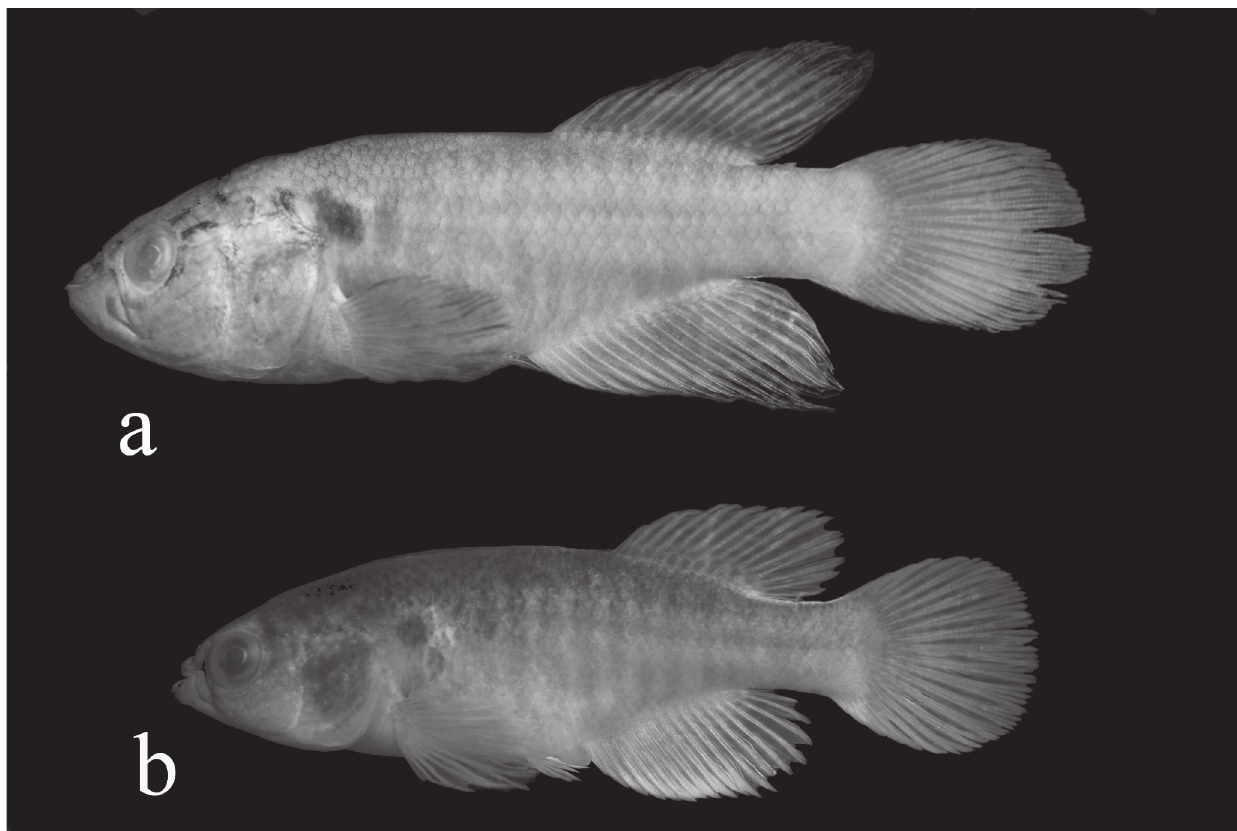
Fig. 1. Cynolebias parnaibensis , Jacobina do Piauí, Piauí, Brazil. ( a ) UFPB 6719, holotype, male, 54.5 mm SL. ( b ) UFPB 6709, paratype, female, 46.2 mm SL.